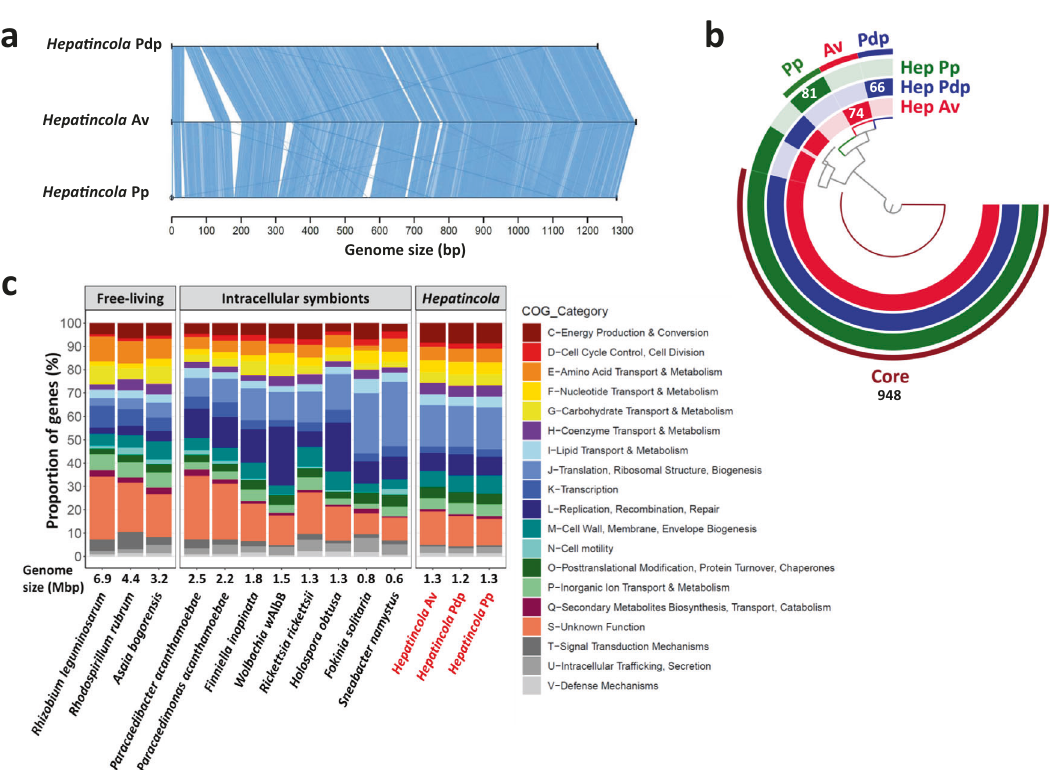
Fig. 2 Comparison of the three Hepatincola genomes. a Synteny plot showing that the synteny is highly conserved between the three genomes. b Pangenome analysis showing that the three Hepatincola strains share a large core genome. Numbers correspond to the number of gene clusters making up the core genome and the strain-speci fi c accessory genomes. c Comparison of COG categories between the three Hepatincola strains and other Alphaproteobacteria , either free-living or intracellular symbionts of arthropods or protists. Genome sizes for each bacterium are provided under the barplot. The three Hepatincola genomes are indicated in